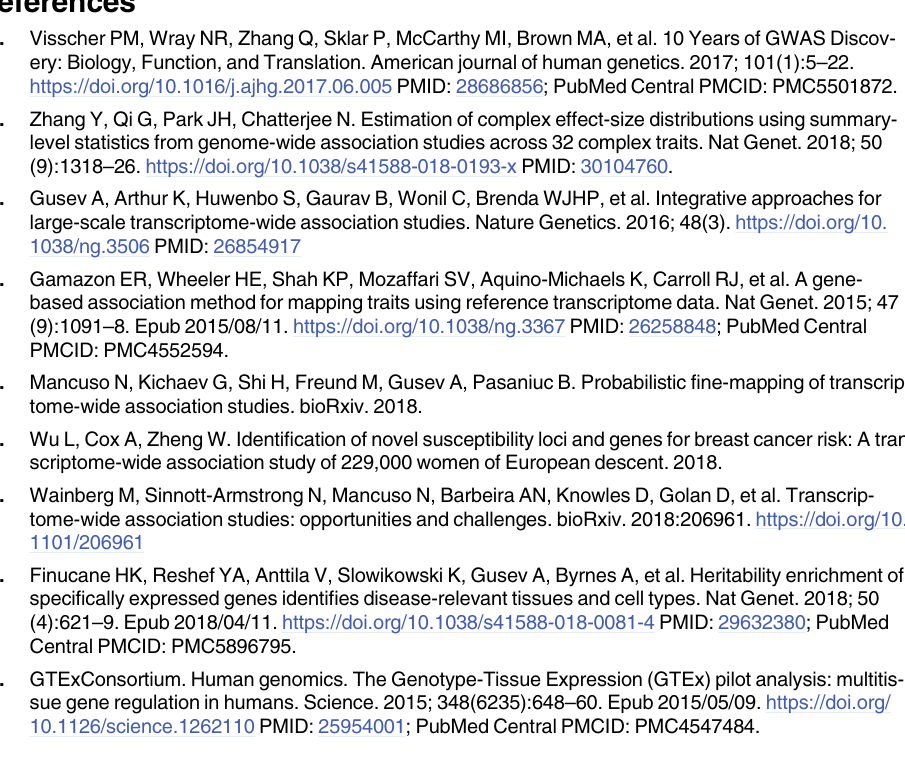
S3 Table. Summary of simulation power when gene expression in all of the tissues corre- lated with the causal tissue. S4 Table. Summary of GTEx expression data. S5 Table. All significant genes identified by sCCA+ACAT for 10 selected phenotypes. S6 Table. Data Application Results for